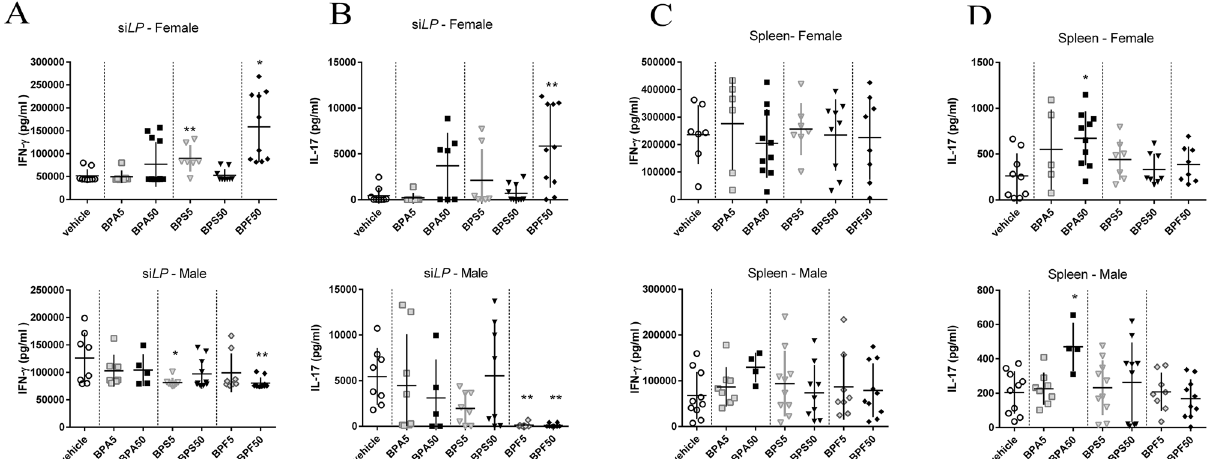
Figure 3. Effects of dermal exposure to bisphenols on Th1/Th17 immune response in adult offspring mice. IFN-γ ( A , C ) or IL-17 ( B , D ) secretion after anti-CD3/CD28 in vitro restimulation of isolated cells from si LP